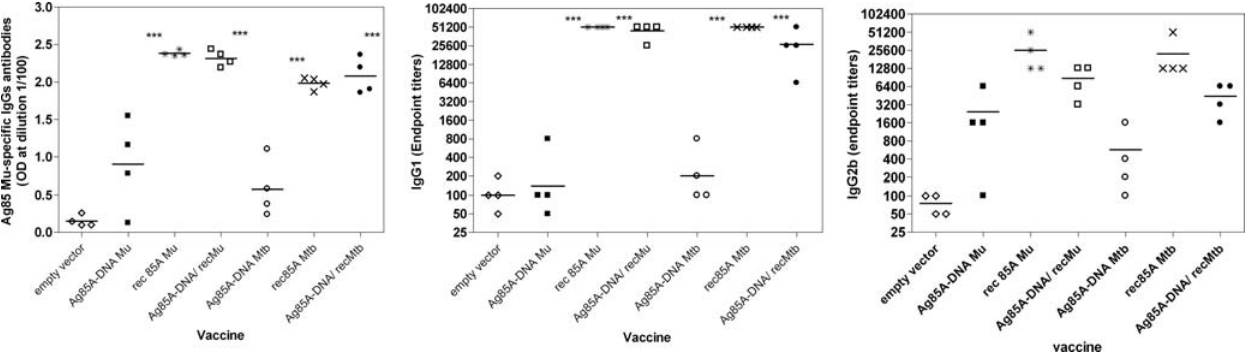
Figure 2. Ag85 M.ulcerans specific total IgG, IgG1 and IgG2b antibody levels in B6 mice. Protein emulsified in Gerbu adjuvant. Data represent individual antibody levels (4 mice/group), mean value is indicated by the horizontal bars. * statistical analysis showing each group with a significant difference. For IgG1, groups c, d, f and g have a significative difference with the others groups. For IgG2b, only rec 85A Mu was significatively different from group a and